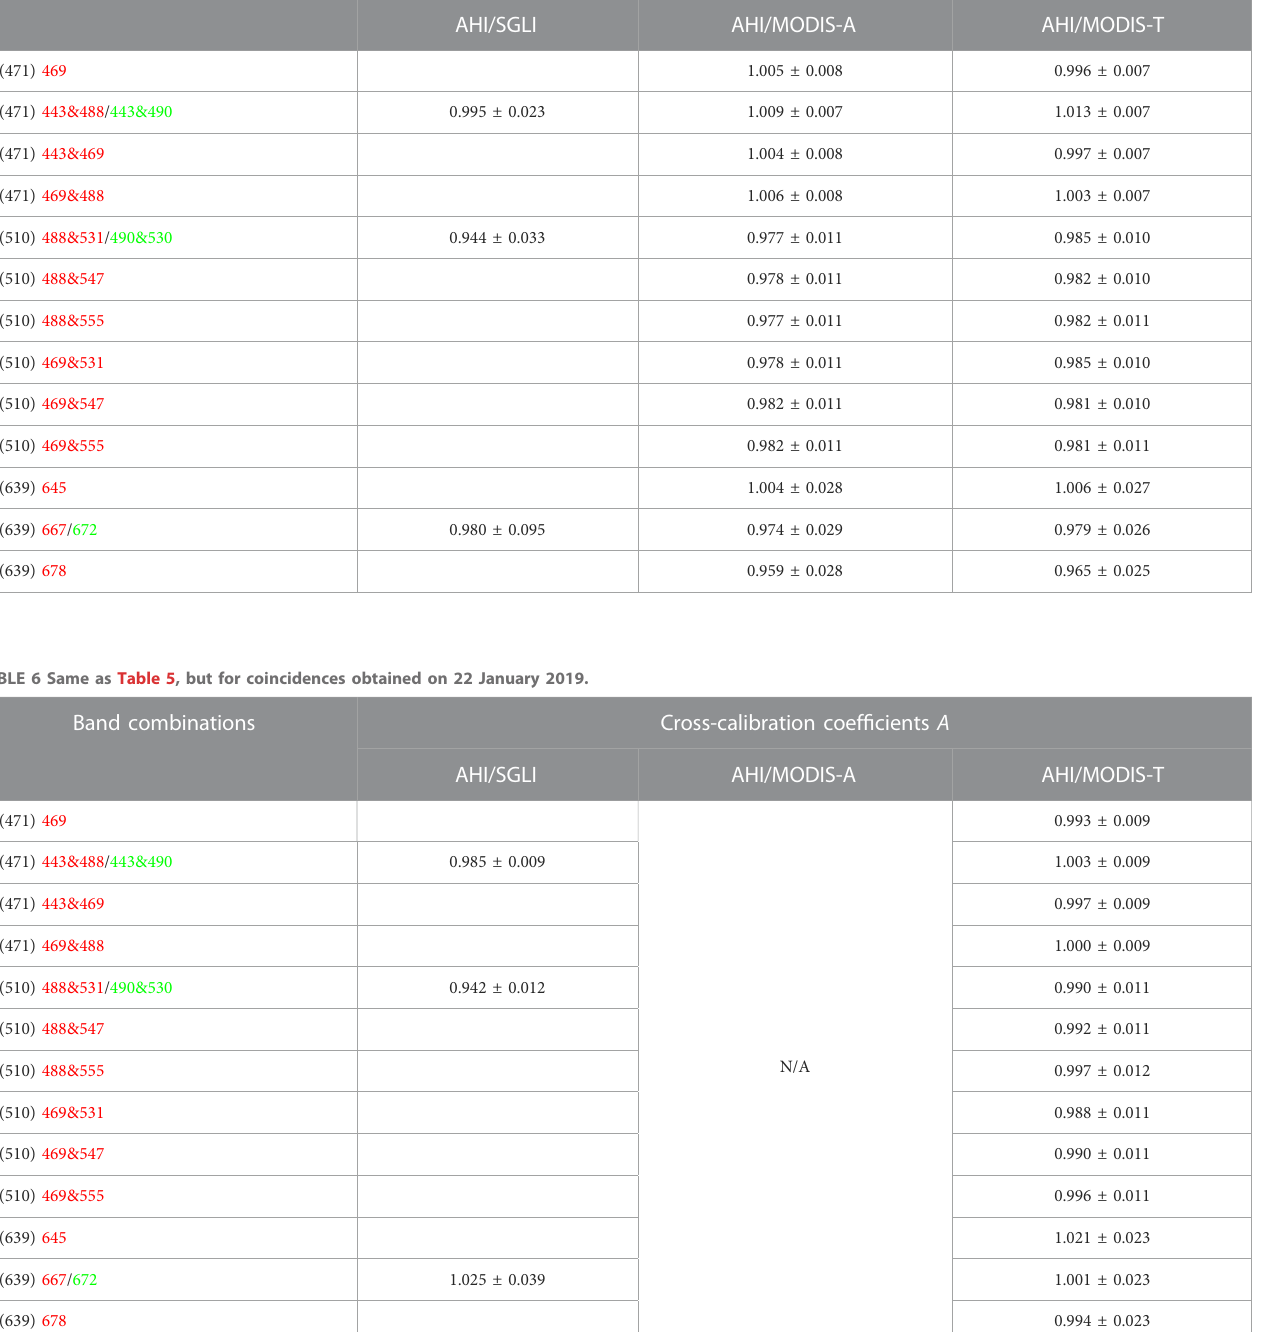
TABLE5Themeansandstandarddeviationsofthecross-calibrationcoef fi cients A forAHI/SGLI,AHI/MODIS-A,andAHI/MODIS-T,obtainedusingMODIS(redfonts)and SGLI (green fonts) band combinations on 11 May 2018. Band combinations